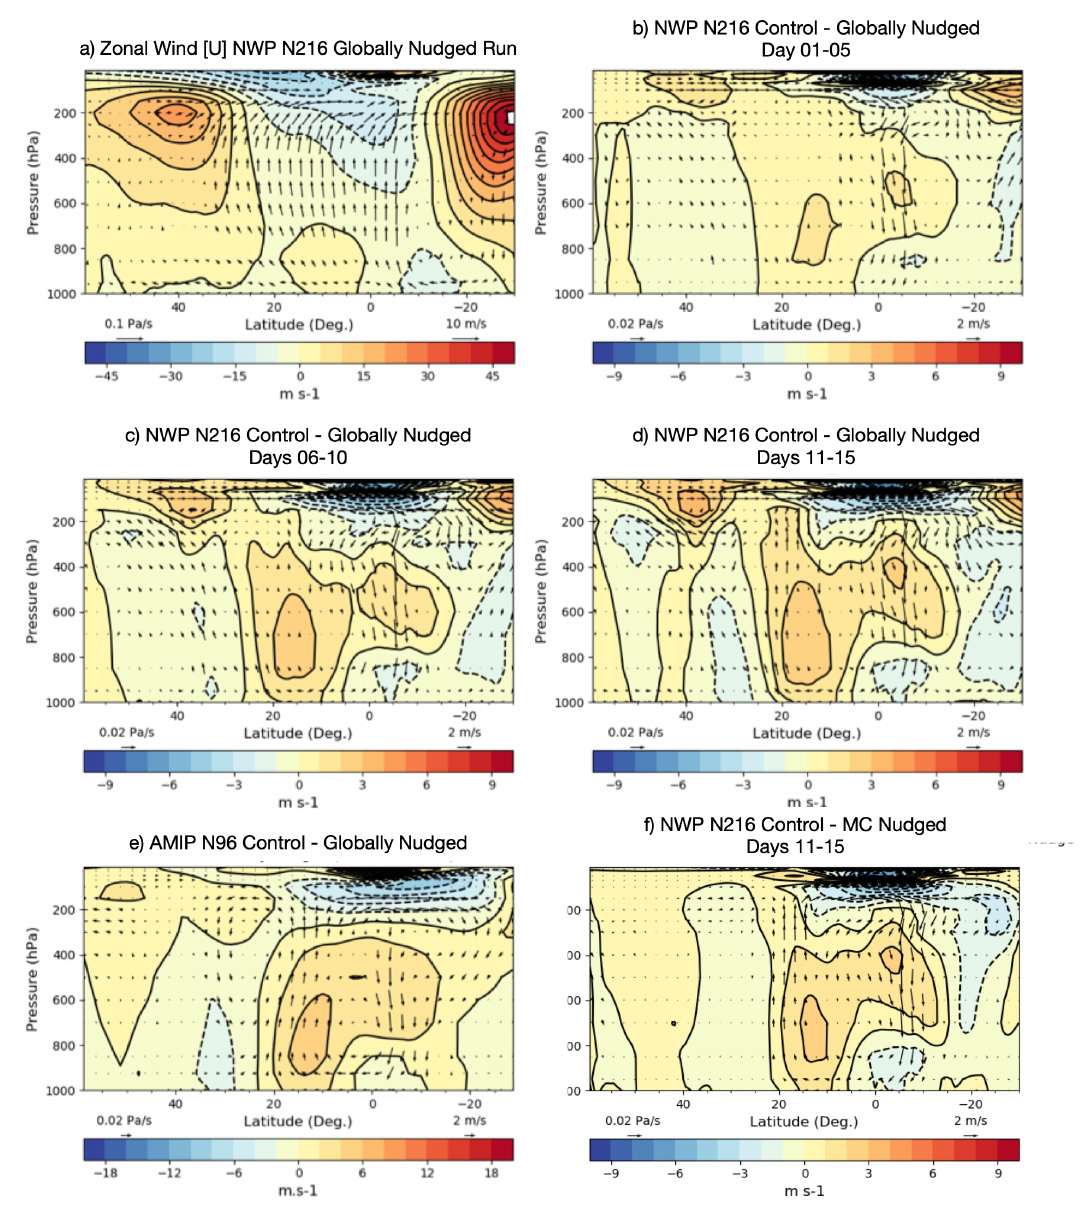
Figure 3. ( a ) June–August 2016 zonal wind ( u , contours) and mean meridional circulation ( v - ω —wind vectors, arrows) averaged over 100 ◦ E–160 ◦ E for NWP-N216 globally nudged run; ( b – e ) NWP-N216 errors, with respect to the globally nudged run, for smoothed forecast lead times of 1–5, 6–10 and 11–15 days; ( e ) June–August 1982–2007 AMIP-N96 mean error; ( f ) NWP-N216 forecast error forced from the Maritime Continent. Winds are expressed in ms − 1